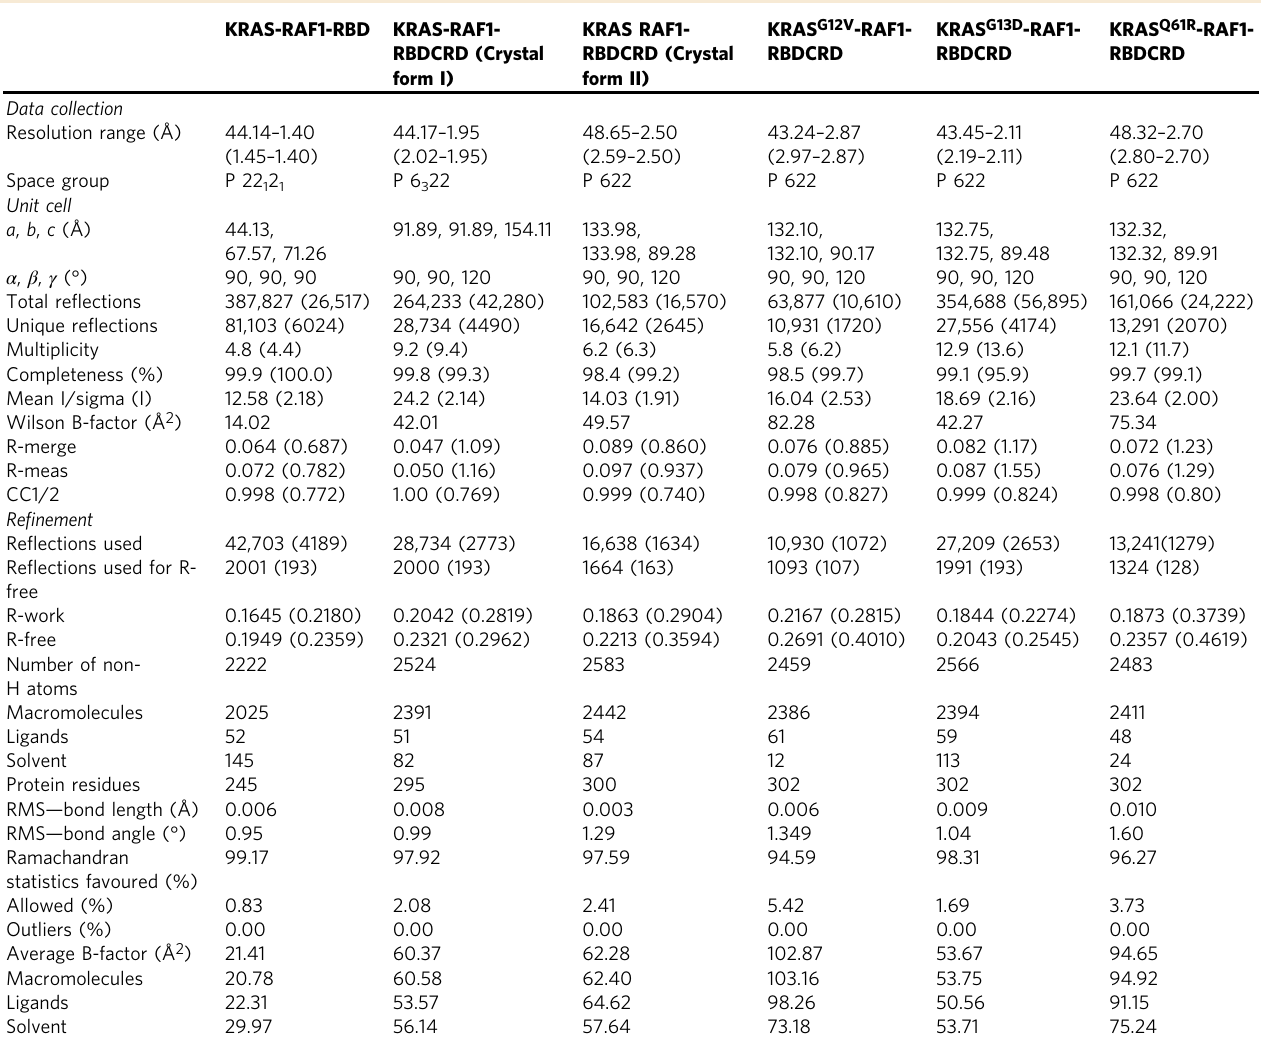
Statistics for the highest-resolution shell are shown in